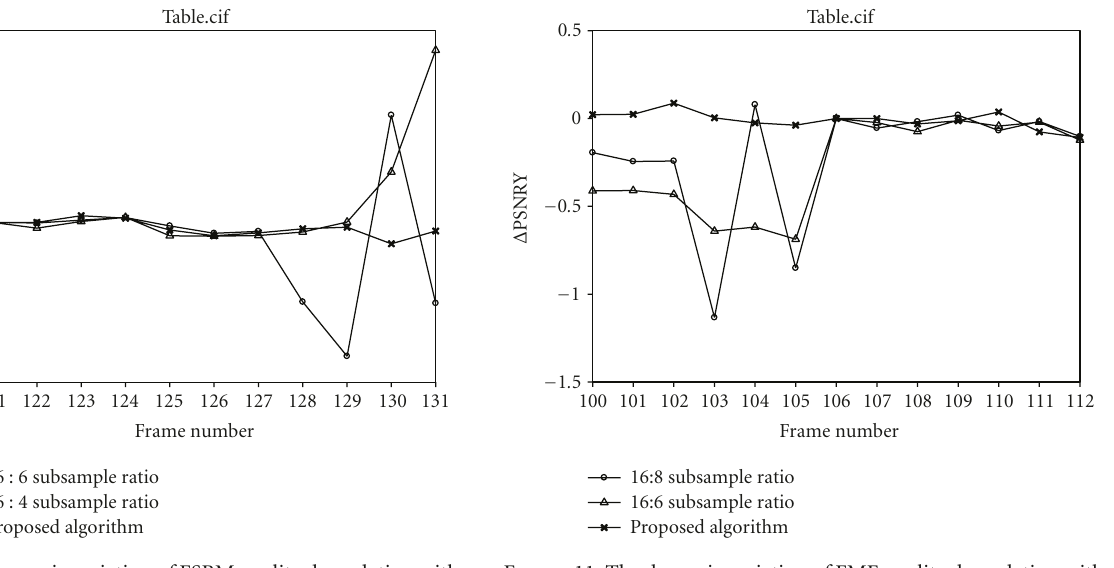
Figure 11: The dynamic variation of FME quality degradation with fixed subsample ratios and proposed